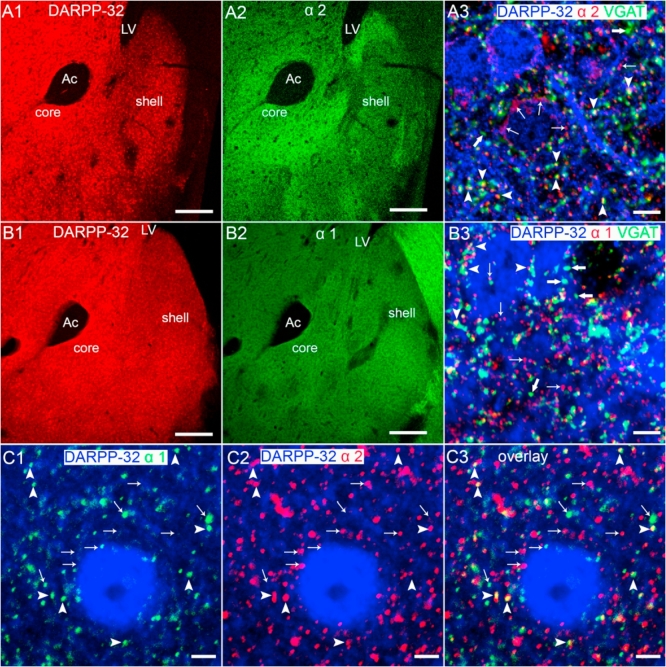
The immunolocalisation of the GABAAR α1 and the α2 subunit in the mouse nucleus accumbens core. (A1, B1) Illustrates the immunoreactivity for DARPP-32, a phospho-protein located selectively in dopamine receptor expressing neurons, which in the ventral striatum delineates the distribution of medium spiny neurons (MSNs). (A2) illustrates that immunoreactivity for the α2-subunit is expressed throughout the ventral striatum and closely follows the distribution of (A1) DARPP-32 immunolabelling, indicating expression in MSNs. Note the enrichment of the α2-subunit immunoreactivity within the core sub-region of the NAc compared to the shell. (A3) shows the association between the immunoreactivity for the GABAAR α2-subunit and the GABAergic axon terminal marker protein vesicular GABA transporter (VGAT) on DARPP-32 immunopositive profiles, which suggests a predominantly synaptic location for this subunit. Numerous α2-subunit immunoreactive clusters are contacted by VGAT immunopositive puncta (arrowheads). However, some α2-subunit immunoreactive clusters are not associated with VGAT puncta (thin arrows), whilst some VGAT puncta are not associated with α2-subunit immunoreactive clusters (thick arrows). (B2) illustrates the immunoreactivity for the GABAAR α1-subunit. In contrast to the α2-subunit staining, note the relatively even distribution of α1-subunit immunoreactivity between the core and the shell sub-regions. (B3) shows the association between immunoreactivity for the GABAAR α1-subunit and VGAT, on DARPP-32 immunopositive profiles, which suggests a predominantly synaptic location for this subunit. Numerous α1-subunit immunoreactive clusters are contacted by VGAT immunopositive puncta (arrowheads). However, some α1-subunit immunoreactive clusters are not associated with VGAT puncta (thin arrows), whilst some VGAT puncta are not associated with α1-subunit immunoreactive clusters (thick arrows). (C) Clusters immunoreactive for (C1) the GABAAR α1-subunit and (C2) the GABAAR α2-subunit are (C3) co-localised (arrowheads) on DARPP-32-immunopositive somata and dendrites. The thin arrows indicate individual clusters, which are not co-localised. Ac = anterior commissure; LV = lateral ventricle. Scale bars: A1,2; B1,2 = 200 μm; A3, B3 = 5 μm; C1-3 = 2 μm.